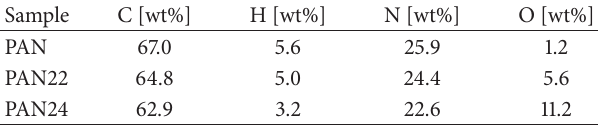
Table 1: Elemental composition of pristine and oxidized PAN.